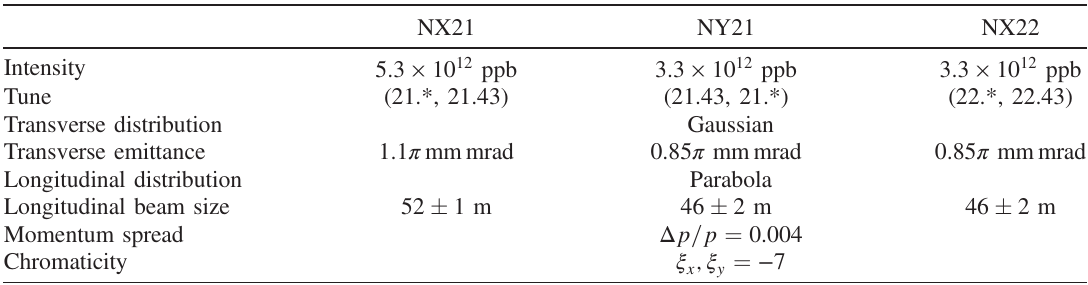
TABLE III. Initial conditions of the